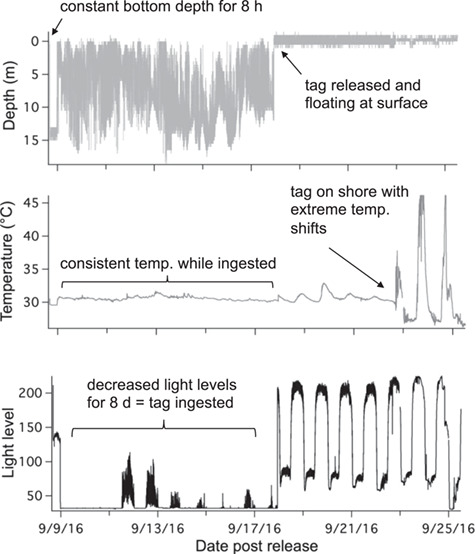
Example of PSAT tag data from an immediate mortality (TX08) showing constant depth an no movement for 8 hours, followed by tag ingestion by a predator